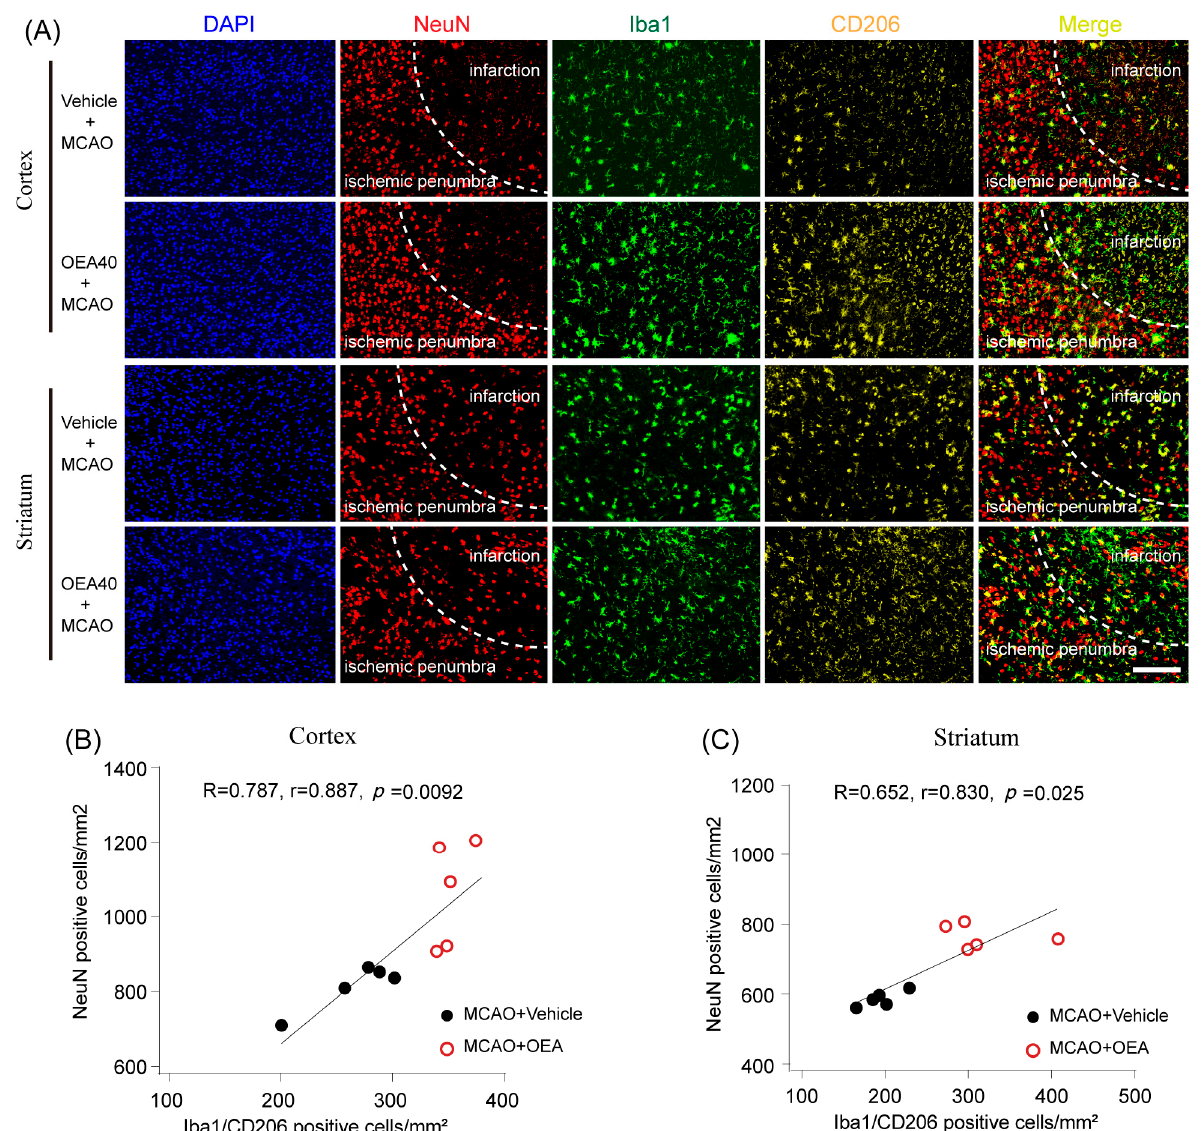
Figure 3. Microglia M2 phenotype elicited by OEA is positively linked with neuron survival after stroke. ( A ) Representative images of NeuN, Iba1 and CD206 triple-staining at 3 d after ischemic stroke. ( B , C ) There was a positive correlation between the number of cells positive for NeuN and Iba1/CD206 positive cells in the injured cortex and striatum at 3 d after MCAO. The data are the means ± SEM. n = 5 per group. Scale Bar = 100 µm.